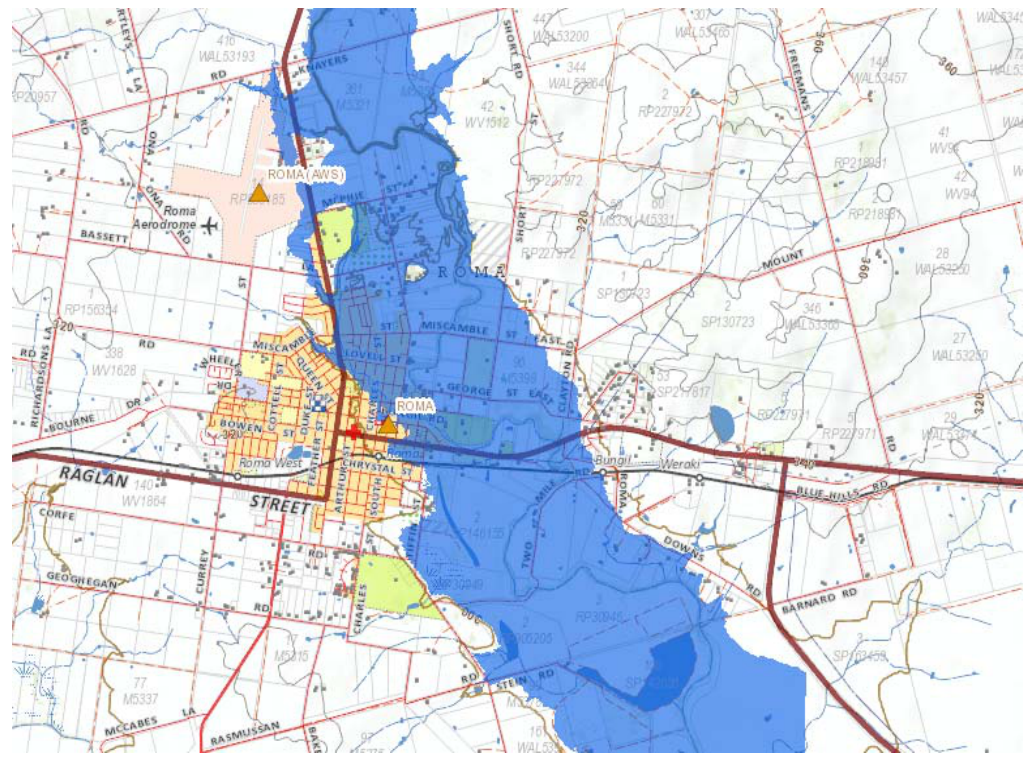
Figure 6. Boundary of the 2012 historic flood event [50].